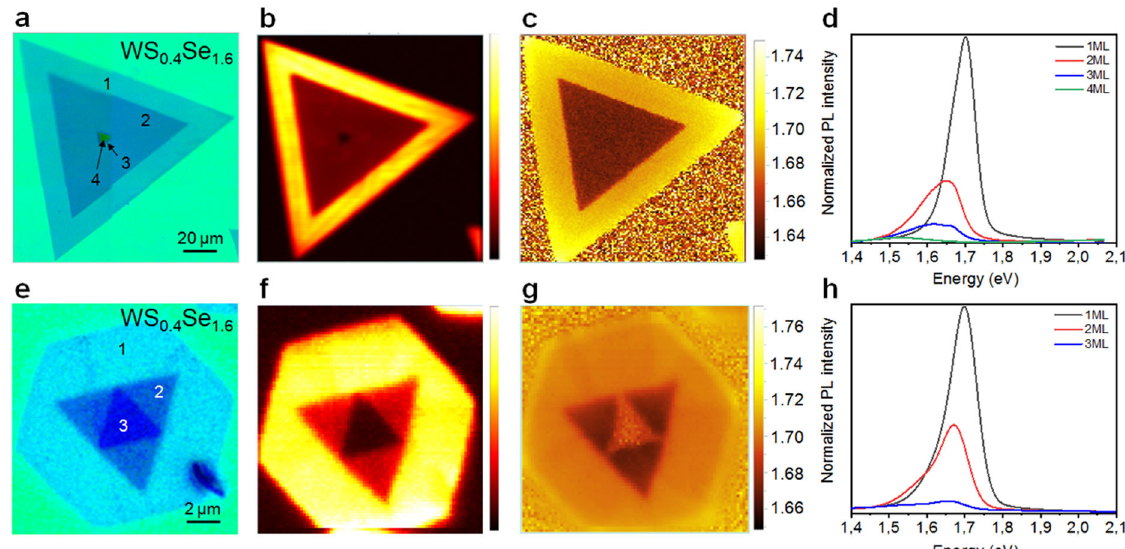
Fig. 2 Optical properties of the WS 2(1 − x ) Se 2 x ( x = 0.8) sample. a , e Optical images obtained from two distinct triangular and hexagonal fl akes, showing that the 1, 2 and 3 ML regions present different optical contrasts. b , f PL intensity maps and c , g peak position maps acquired on the triangular and hexagonal fl akes of a , e with a 532 nm laser excitation. d , h Typical PL spectra obtained from different positions on the fl akes of a , e indicated by 1 – 4 in ( a ), corresponding to 1, 2, 3 and 4 ML,